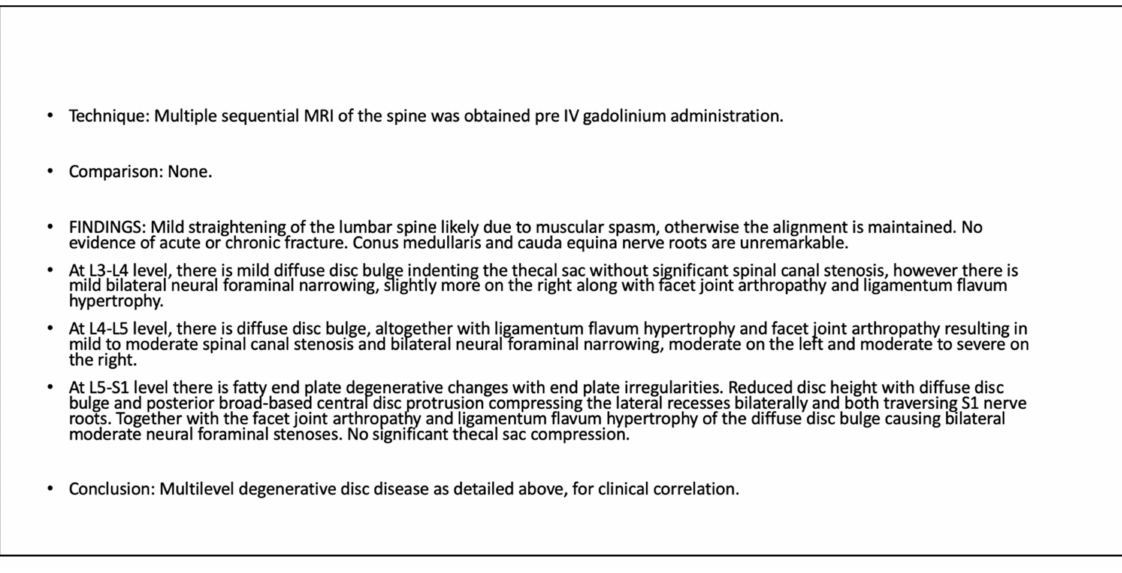
Figure 2. Original design of the MRI lumbar spine